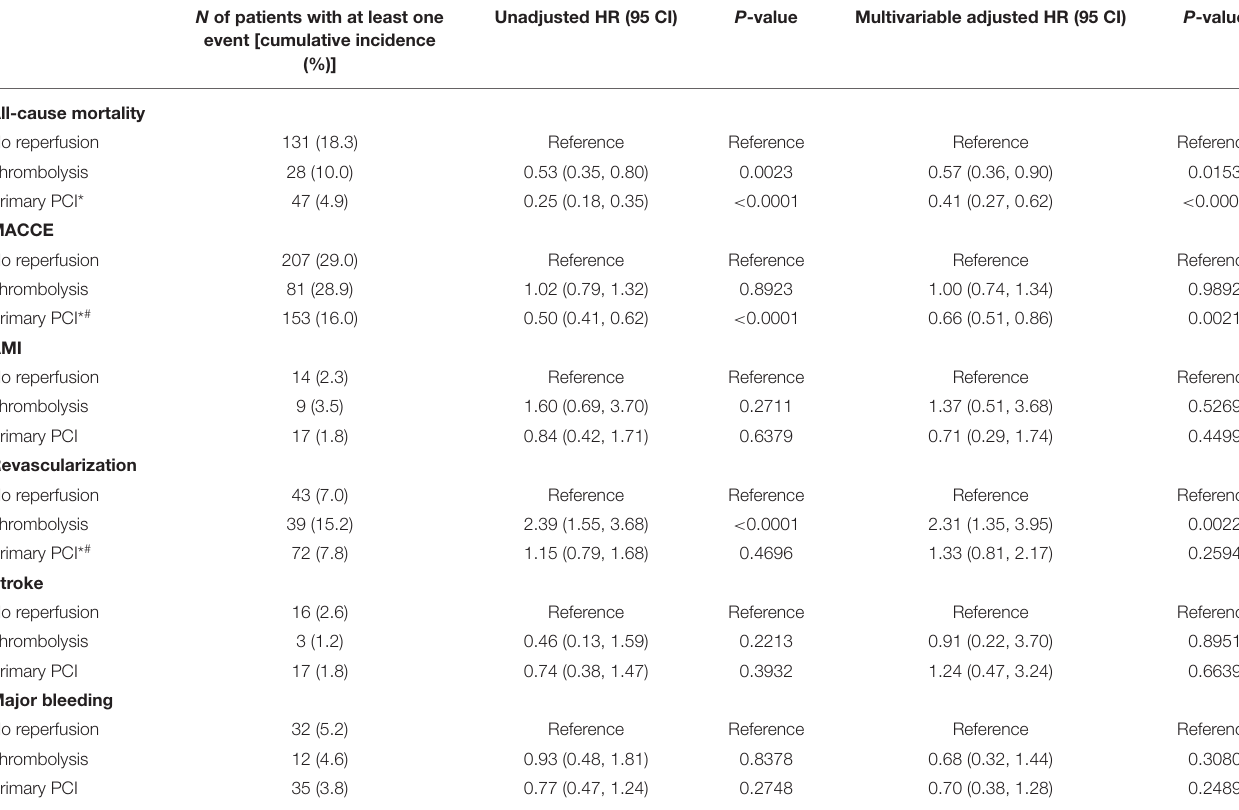
TABLE 4 | Clinical outcomes at 1-year according to treatment strategies in patients with right ventricular infarction. N of patients with at least one event [cumulative